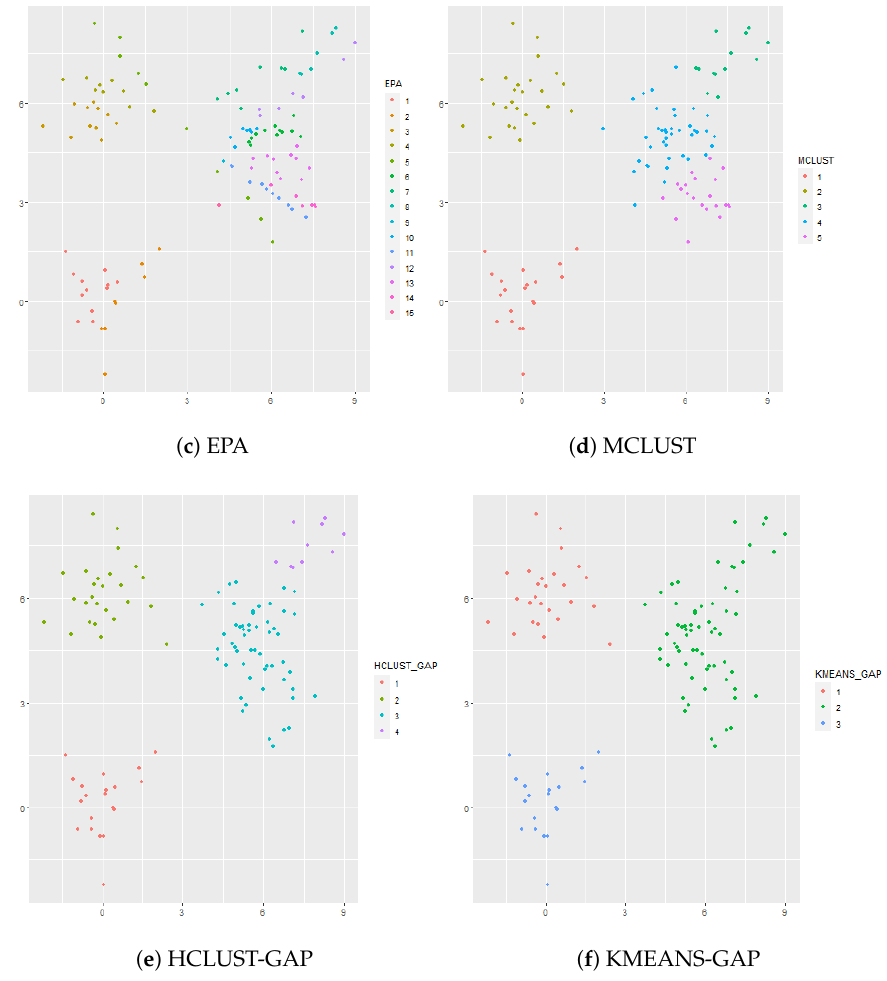
Figure 2. Panel ( a ) shows the true cluster assignments when p = 2, K ∗ = 4, and n = 110. Panel ( b ) shows the posterior TIP cluster assignments, Panel ( c ) shows the posterior EPA assignments, Panel ( d ) shows the MCLUST assignments, Panel ( e ) shows the hierarchical clustering assignments where the number of clusters is determined via the gap statistic, and Panel ( f ) shows the k-means clustering assignments where the number of clusters is determined via the gap